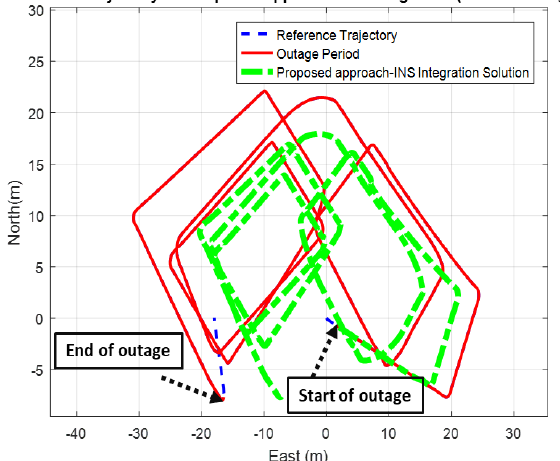
Figure 19. Solution of the proposed approach integrated with